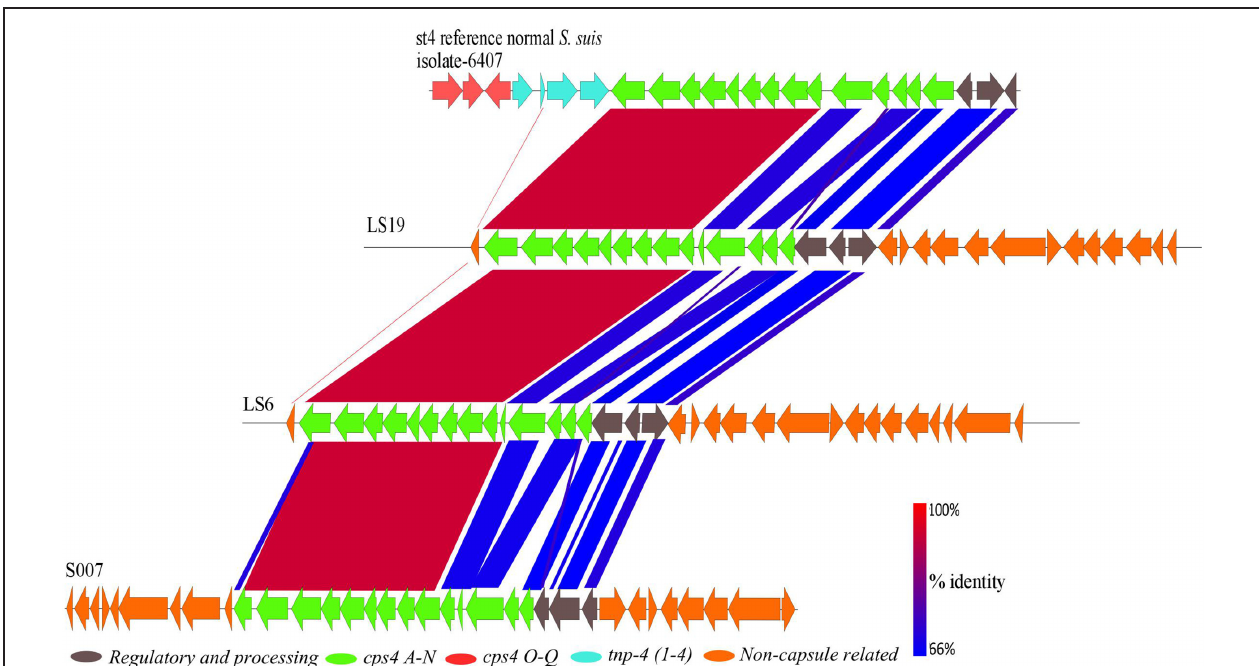
FIGURE 5 | A BLASTn alignment of the 26.5 kbp capsular region of the normal S. suis serotype 4 reference isolate (top) with the divergent serotype 4 isolates, constructed using